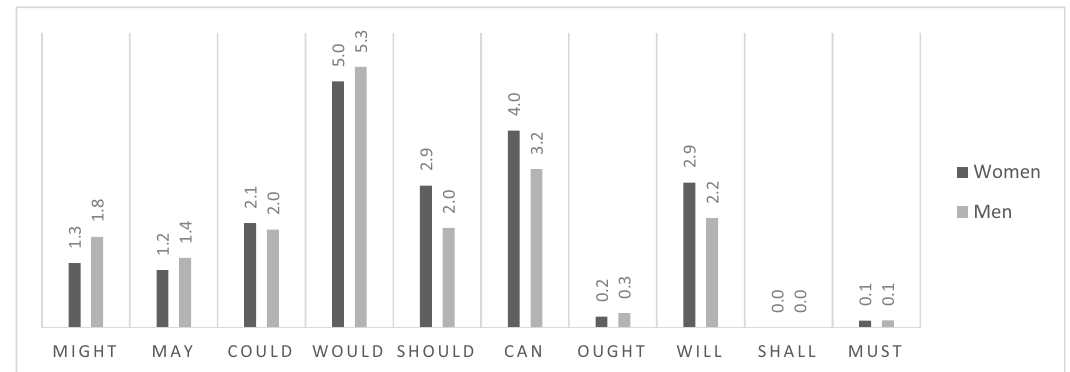
Figure 2: Modal auxiliary frequency of use ( normalised, n = 1,000 ) , arranged by increasing possibility/capacity and social sanction. χ 2 ( df = 9, n = 1,000 ) = 124, p ≤